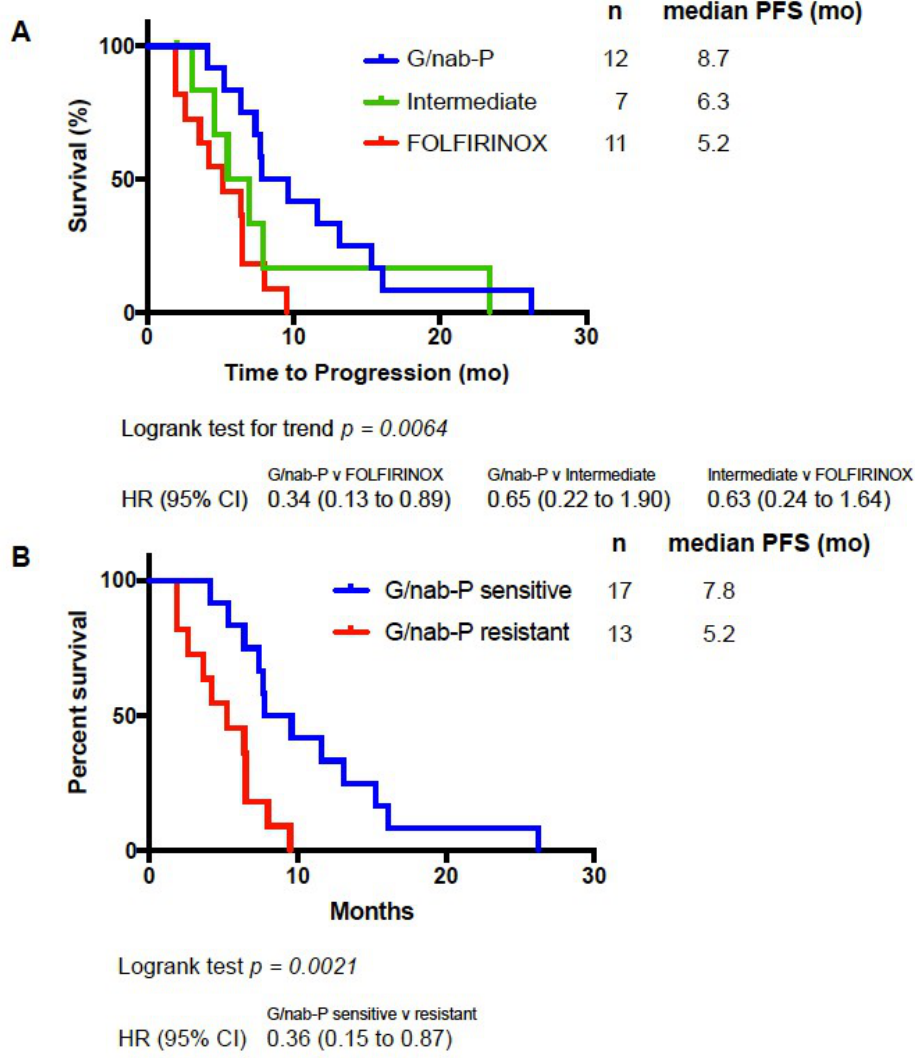
Figure 1. Kaplan–Meier analysis of progression-free survival (PFS) of patients treated with G/nab-P based on classification into one of three PGx profiles ( A ), and based on predicted G/nab-P sensitivity ( B ).